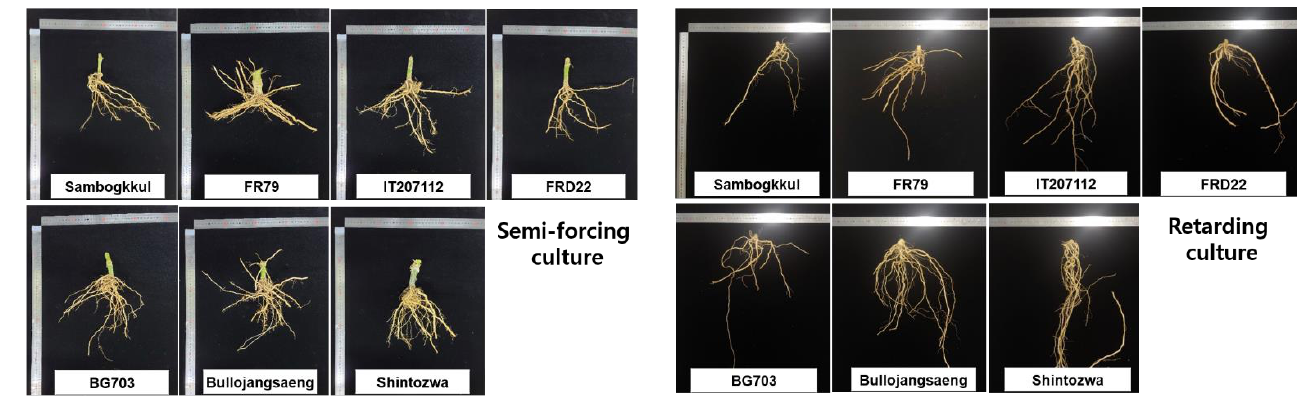
Figure 7. The stem diameter of graft union and ratio of stem diameter between scion and rootstock influenced by bottle gourd rootstocks before harvesting. Different letters indicated a significant difference within the column at the p ≤ 0.05 according to Duncan’s multiple range test.